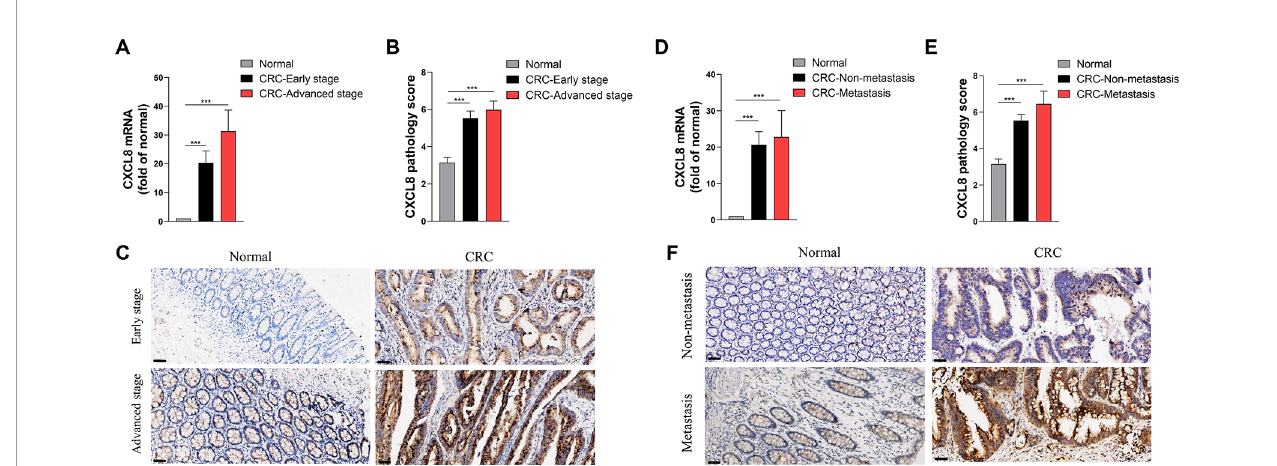
FIGURE 3 | Expression levels of CXCL8 in the clinical cohort. (A) The levels of CXCL8 mRNA in the normal (N = 81), colorectal cancer (CRC)-early stage (N = 44) and CRC-advanced stage (N = 37) groups. (B) The levels of CXCL8 protein in normal (N = 87), CRC-early stage (N = 48), and CRC-advanced stage (N = 39) groups. (C) Immunohistochemical staining of normal, CRC-early stage and CRC-advanced stage groups. (D) The levels of CXCL8 mRNA in normal (N = 70), CRC- nonmetastasis (N = 58) and CRC-metastasis (N = 12) groups. (E) The levels of CXCL8 protein in normal (N = 87), CRC-nonmetastasis (N = 69) and CRC-metastasis (N = 18) groups. (F) Immunohistochemical staining of normal, CRC-nonmetastasis and CRC-metastasis groups. Scale bar = 50 m m. Statistical signi fi cance was performed by the Mann-Whitney U test. *** p <